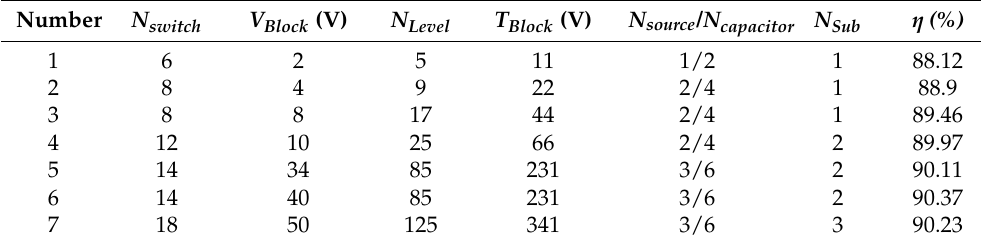
Table 6. Comparison of proposed topology for various output voltage levels for same power